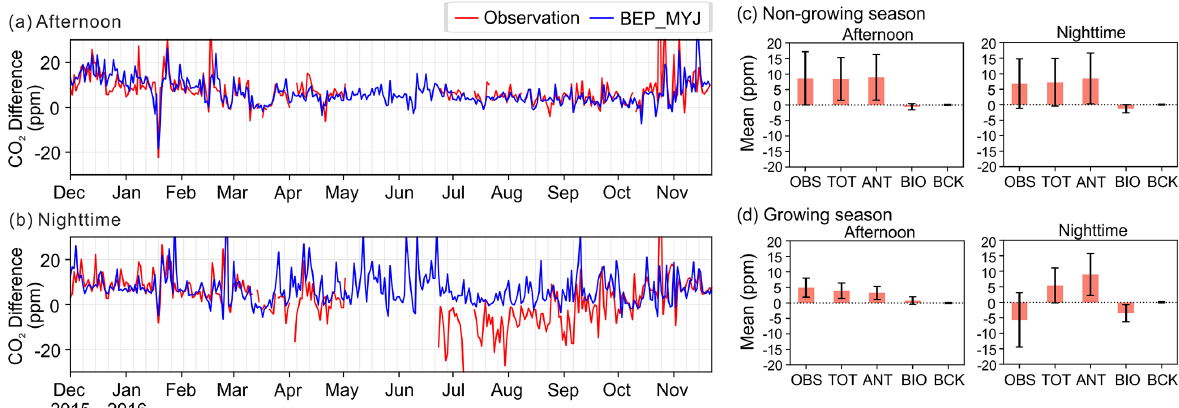
Figure 9. Daily (a) afternoon mean (11:00–16:00UTC) and (b) nighttime mean (21:00–05:00UTC) CO 2 horizontal differences between CDS and SAC. Daily CO 2 horizontal differences between CDS and SAC from each sector for (c) the non-growing season from October to April and (d) the growing season from May to September. OBS indicates the observed CO 2 concentration differences. TOT, ANT, BIO, and BCK indicate the simulated total, anthropogenic, biogenic, and background CO 2 concentration differences